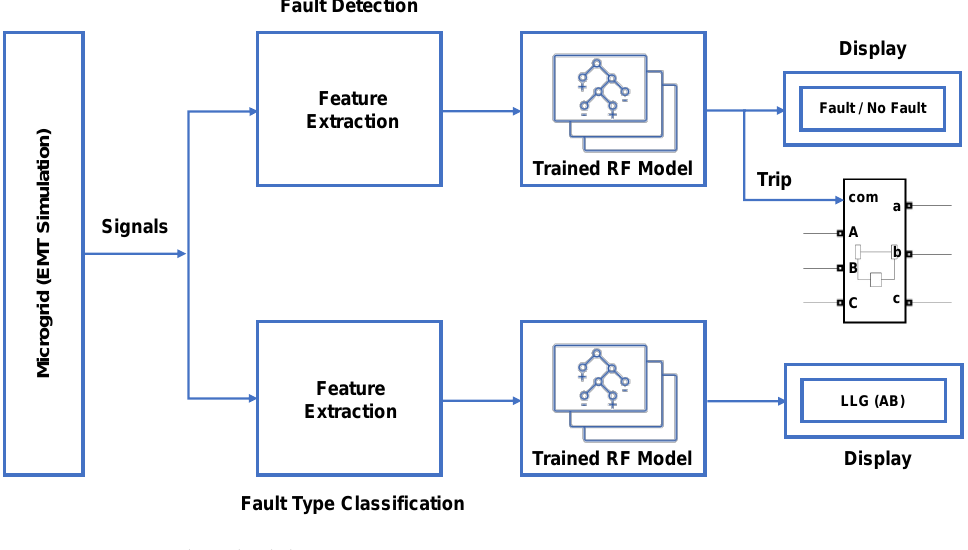
Figure 22. Proposed methodology.